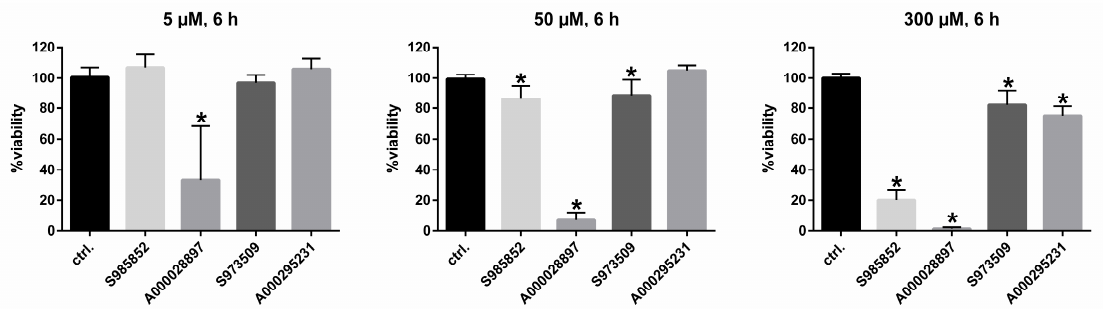
Figure 4. Cytotoxicity studies in NTCP-HepG2 cells. An MTT cytotoxicity assay was performed with the indicated propanolamine derivatives at 5 µ M, 50 µ M, and 300 µ M inhibitor concentrations, incubated over a time span of 6 h at 37 ◦ C. Solvent control was set to 100%. Data represent means ± SD of two independent experiments, each with quadruplicate determinations ( n = 8). * Significantly different to control with p < 0.01.